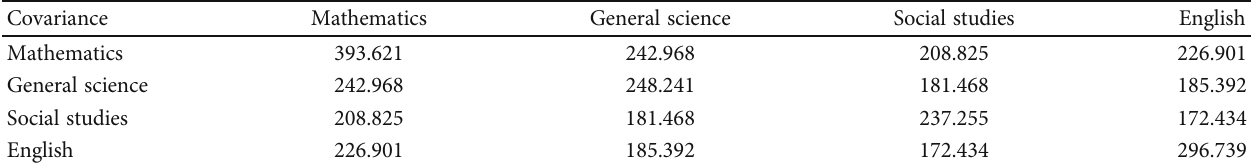
Table 9: The covariance for total urban students.